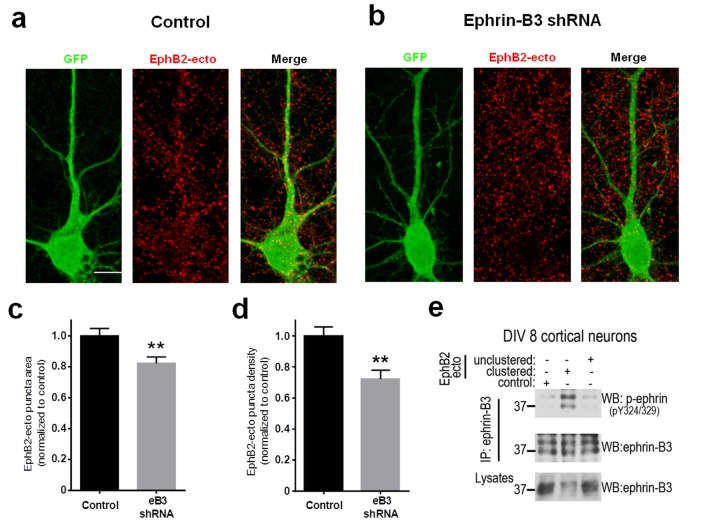
Validation of unclustered EphB2 ectodomain treatment method.(a and b) Representative images of DIV10 cortical neurons transfected with GFP and either pSuper control vector (control) or eB3 shRNA and treated with 500 ng/ul (250 ng/well) EphB2 ectodomain (EphB2-ecto). Neurons were stained for GFP (green) and EphB2 ectodomain (red). Scale bar, 10 μm. (c) Quantification of EphB2 puncta density normalized to control neurons within each experiment (Control, n = 26; eB3 shRNA, 28; t(52)=3.26, **p=0.002, two-tailed Student’s t-test). (d) Quantification of EphB2 puncta area normalized to control neurons within each experiment (Control, n = 26; eB3 shRNA, 28; t(52)=2.887, **p=0.0056, two-tailed Student’s t-test). (e) Representative western blots of DIV8 neuronal lysates treated with either clustered or unclustered EphB2 ectodomain. Treatment of neurons with the unclustered form of EphB2 ectodomain did not activate ephrin-B3 as shown by probing the immunoprecipitates (ephrin-B3 IP) with an antibody specific to tyrosine-phosphorylated (activated) ephrin-Bs.10.7554/eLife.41563.012Figure 4—figure supplement 1—source data 1.Validation of EphB2 ectodomain treatment method.